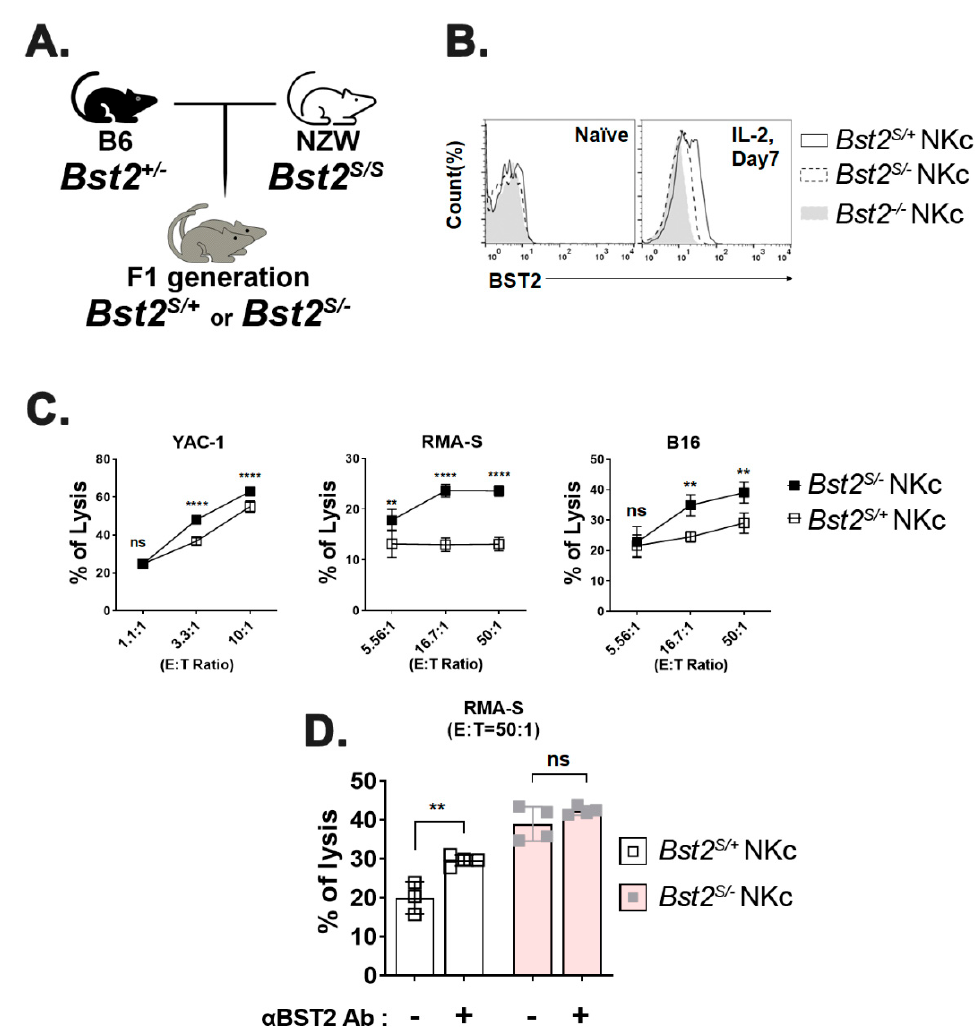
Figure 4. Long isoform, but not short isoform, of BST2 on NK cells impedes cytotoxicity. ( A ) F1 hybrids were generated by crossing B6-origin Bst2 +/- mice and NZW mice ( Bst2 S/S ). ( B ) Naïve splenocytes of F1 hybrids and B6-origin Bst2 -/- mice were stimulated by IL-2 for seven days to generate LAK cells. Expression of BST2 was detected through flow cytometry staining. ( C ) CFSE stained Bst2 S/+ and Bst2 S/- LAK cells were co-cultured with target cells (YAC-1, RMA-S, and B16) for 4 hrs at 37 ° C in a humidified incubator. Cells were stained with 7-AAD after cultivation. These cells were then fixed with 1% paraformaldehyde and analyzed by FACS. CFSE-, 7-AAD+ population is designated as lysed target cells. Graphs showed a mean ± S.D. ( n = 4 per group). ( D ) CFSE stained Bst2 S/+ and Bst2 S/- LAK cells from F1 hybrids were co-cultured with target cells (RMA-S) cells for 4 hrs at 37 °C in a humidified incubator in absence or presence of anti-BST2 antibody. Graphs showed mean ± S.D. ( n = 3–4 per group). (**, p < 0.01; ****, p < 0.0001; n.s., not significant). To verify whether the inhibitory signal was transduced through BST2, we compared cytotoxicities of Bst2 S/+ NK cells and Bst2 S/- NK cells after treatment with anti-BST2 anti- body. While blocking BST2 on Bst2 S/+ NK cells significantly enhanced NK cell cytotoxicity, the same blocking on Bst2 S/- NK cells showed only a marginally insignificant enhancement of cytotoxicity (Figure 4D). This suggests that the N-terminal cytoplasmic tail of BST2 is critical to NK cell suppression.